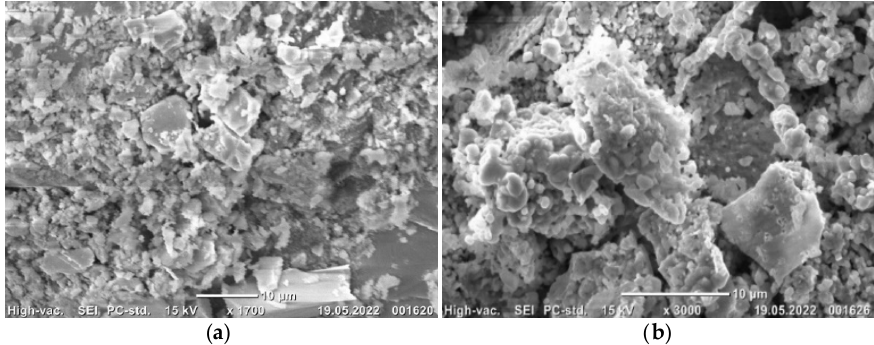
Figure 3. SEM images of raw ( a ) and calcined at 900 ◦ C ( b ) natural